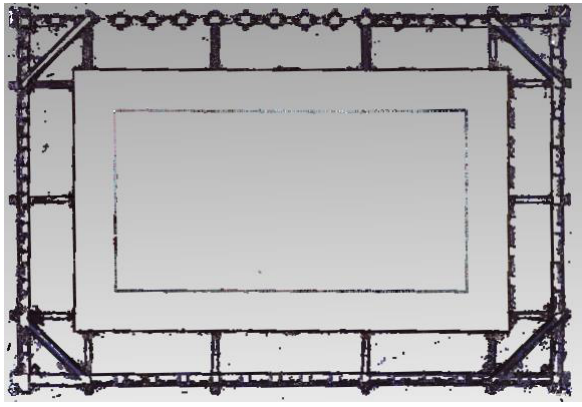
Figure 3. Point cloud slice image